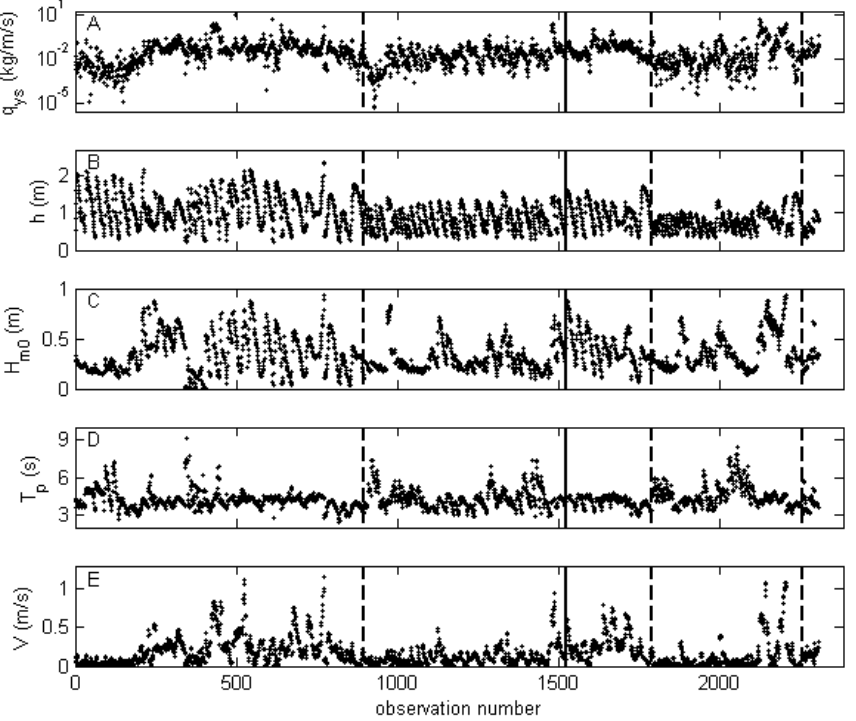
Fig. 1. Tripod observations: (A) Depth-integrated suspended sediment transport (a log-scale is employed), (B) water depth, (C) significant wave height, (D) peak wave period, (E) alongshore velocity. The vertical dashed lines separate data obtained from different tripods (tripods were measuring simultaneously, but each dataset is characterized by a different length because of the different time that each tripod was submerged). The vertical solid lines at observation 1522 indicate the difference between the “training” (first 66% of the data) and the “testing” (last 33% of the data) datasets.